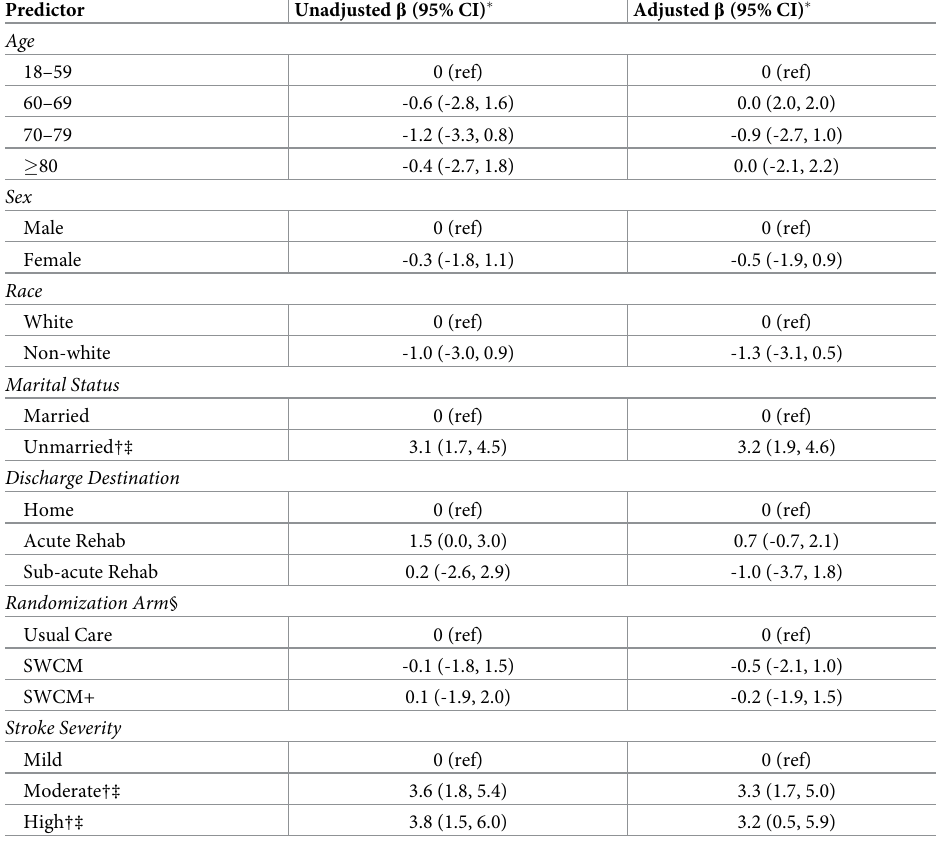
Table 3. Final multivariable linear regression analysis of change in PHQ-9 score from 7 days to 90 days (n = 378 observations from 214 unique